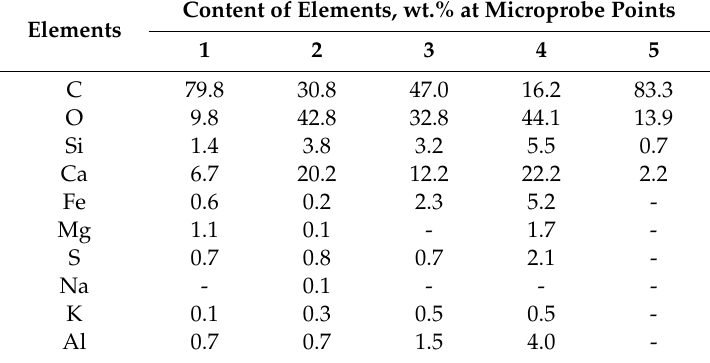
Table 7. The composition of the hydration products of the gypsum-cement binder- fly ash (GCB-FA) at microprobe points.